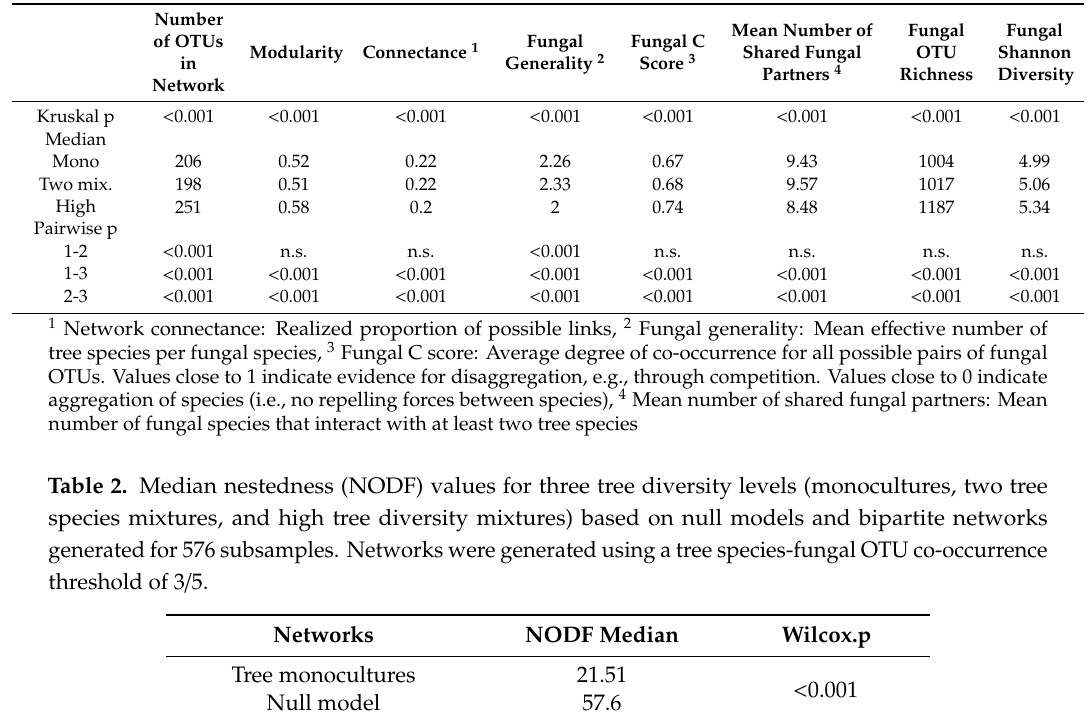
Table 1. Calculated network metrics for di ff erent levels of tree species diversity based on 576 tree-fungal bipartite subsamples and three tree diversity levels: monocultures (“Mono”), two-tree species mixtures (“Two mix.”) and high tree diversity mixtures (“High”). The Kruskal-Wallis test was used to identify significant di ff erences in network values across the tree diversity levels. The median values of the network characteristics are reported for each tree diversity level. The Kruskal-Wallis test for multiple comparisons with the Bonferroni-Holmes correction was used to assess the significance of pairwise di ff erences in network characteristics across tree diversity levels (n.s.: no significant di ff erence detected). Numbers indicate the tree diversity levels: 1-monocultures, 2-two tree species mixtures, 3-high diversity tree species mixtures. Results are shown for networks generated using a tree species-fungal OTU co-occurrence threshold of 3 / 5.